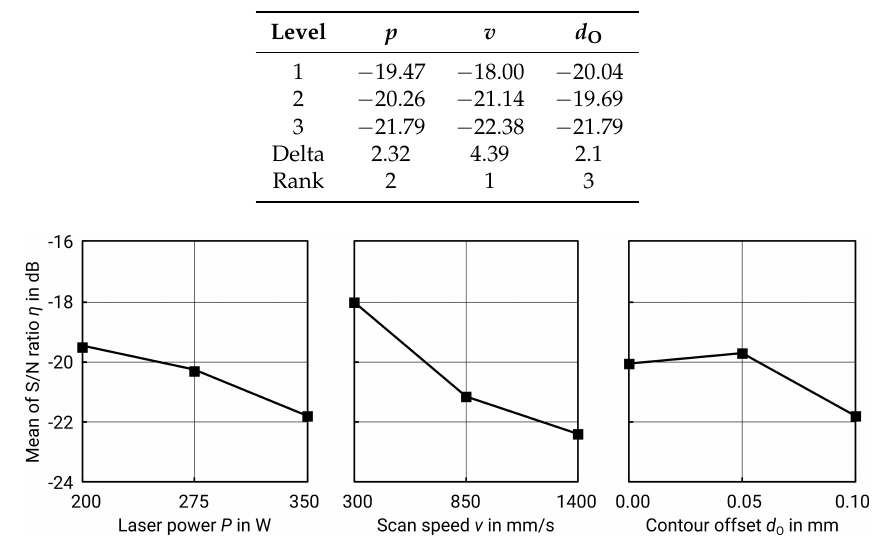
Table 6. Average S/N ratios for vertical surfaces (contour).